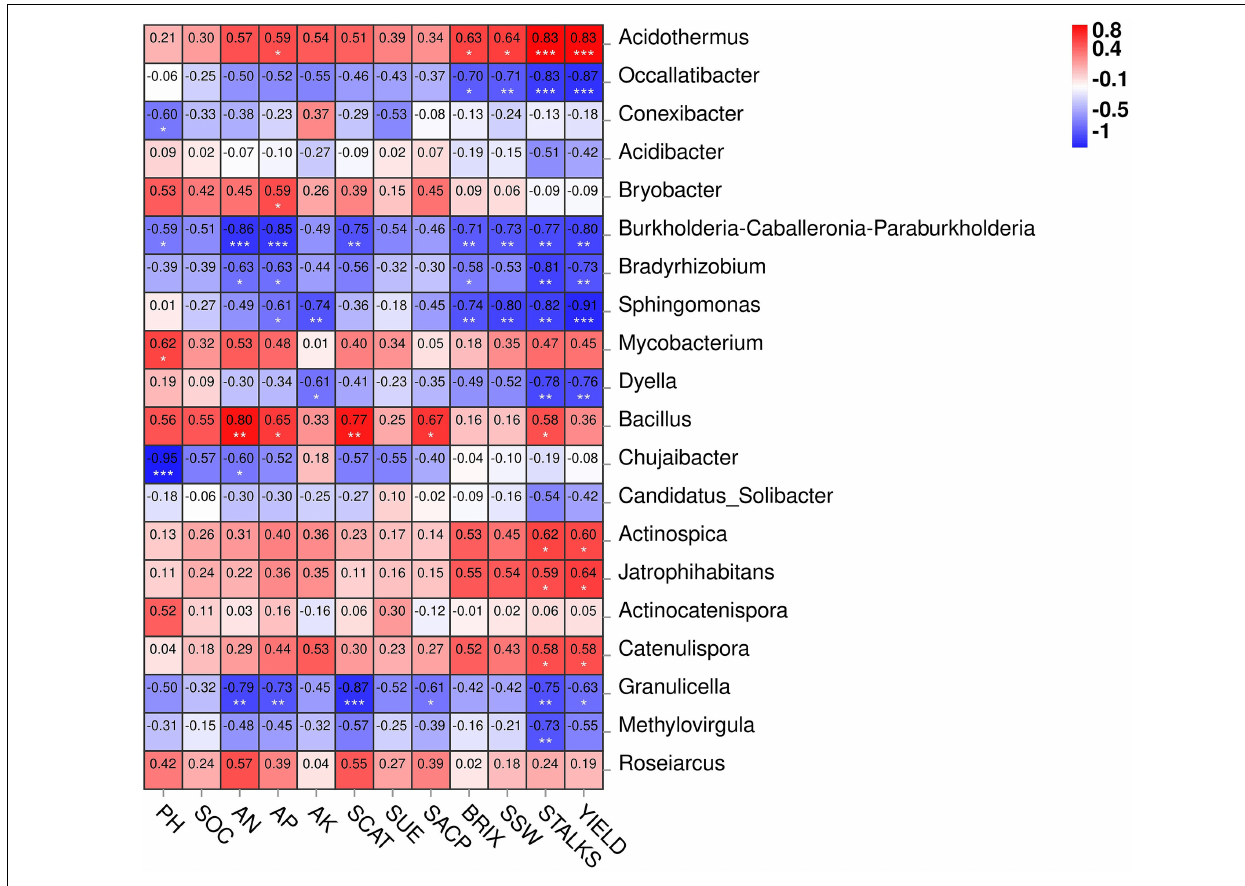
FIGURE 8 | Heatmap of Spearman correlation between environmental factors and top 20 bacterial genera. The legend represents level of correlation. * Significance at P < 0.05, ** significance at P < 0.01, *** significance at P <